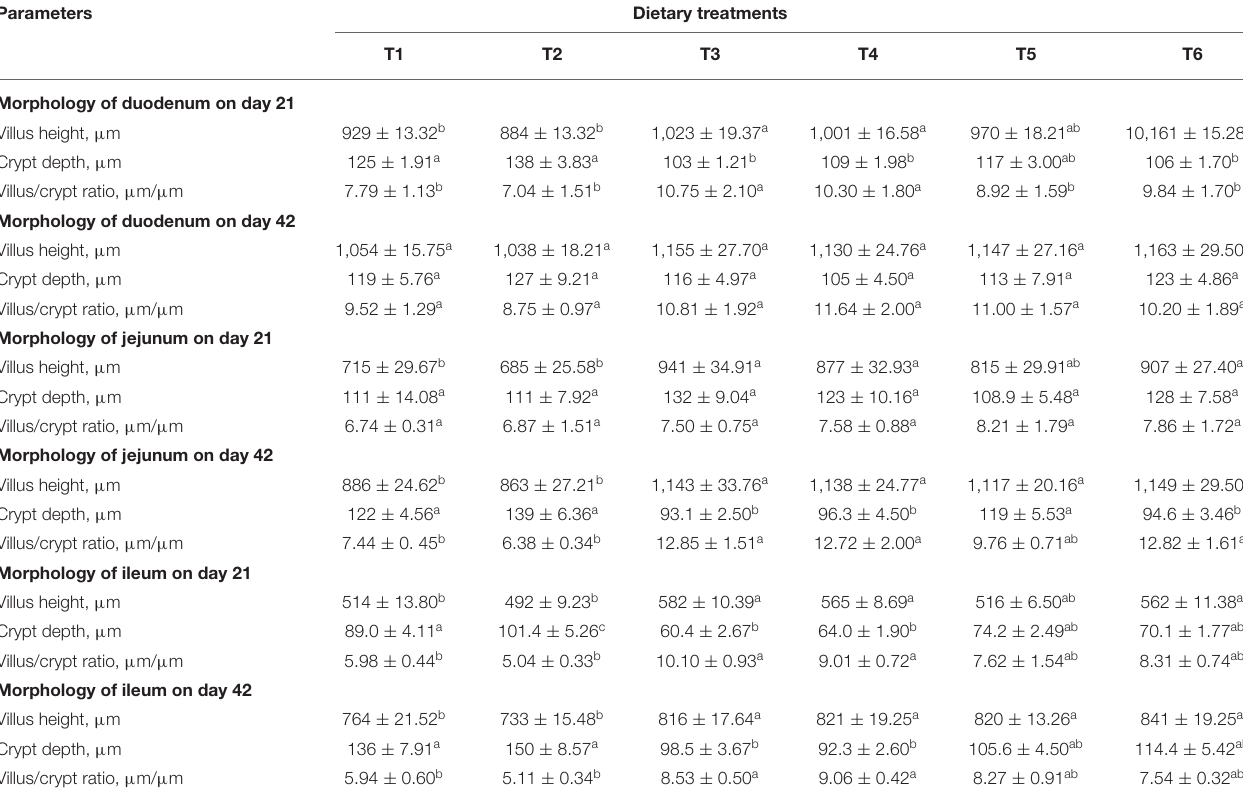
TABLE 5 | Effect of different dietary treatments on histomorphometry of duodenum, jejunum and ileum of broilers ( n = 6 chicks per treatment, mean ± SE). Parameters Dietary